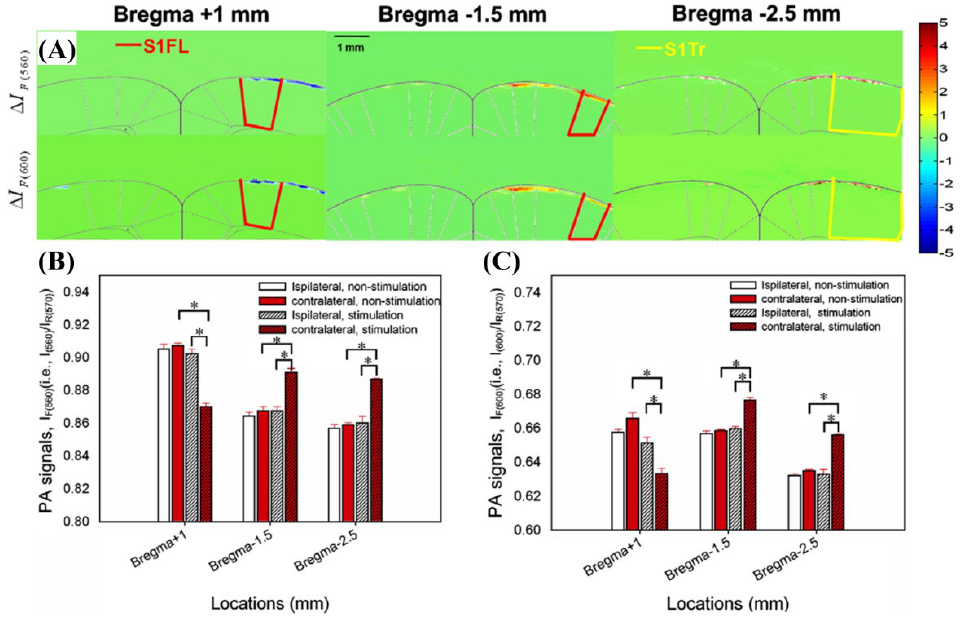
Figure 24. ( A ) In vivo functional ΔI F(560) (upper panels) and ΔI F(600) (lower panels) images registered and fused with the rat atlas at bregma +1, −1.5, and −2.5 mm. ( B ) Quantitative analysis of the I F(560) signal changes in the bilateral ROIs between the stimulation-ON and -OFF conditions. ( C ) Quantitative analysis of the I F(600) in the bilateral ROIs between the stimulation-ON and -OFF conditions. Reprinted from Liao et al . , Neuroimage, 2010, 52, 2: 562–570 [40], with permission from Elsevier.